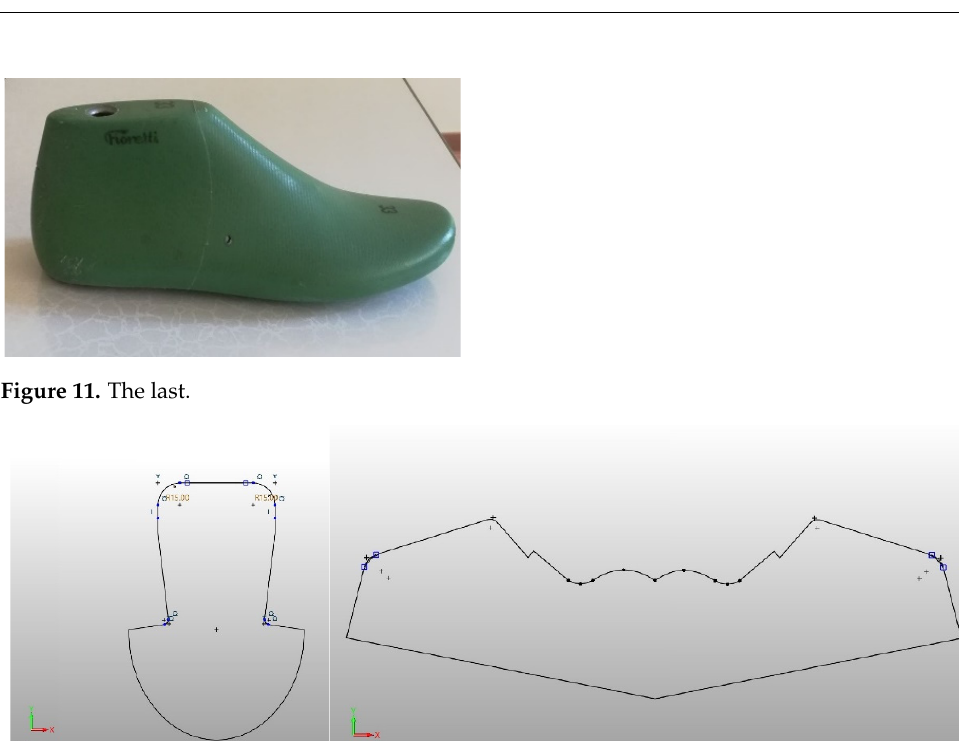
Figure 10. A model of the sports and leisure footwear.